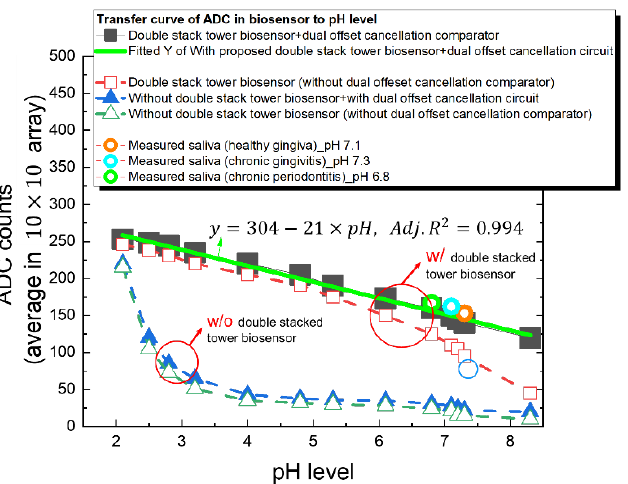
Figure 20. The transfer curves of ADC read-counts versus pH level in proposed biosensor. The fitted equation (green line in Figure) of the proposed biosensor with dual offset cancellation comparator shows a wide linear range from pH 2.0 to pH 8.3. Without double stacked tower biosensor, the overall linearity is divided into two parts, with steeper sensitivity at pH 2.0–3, and less sensitivity at pH 3.0–8.3, making it difficult to distinguish the chronic disease gingiva saliva at pH 6.8 – 7.3.